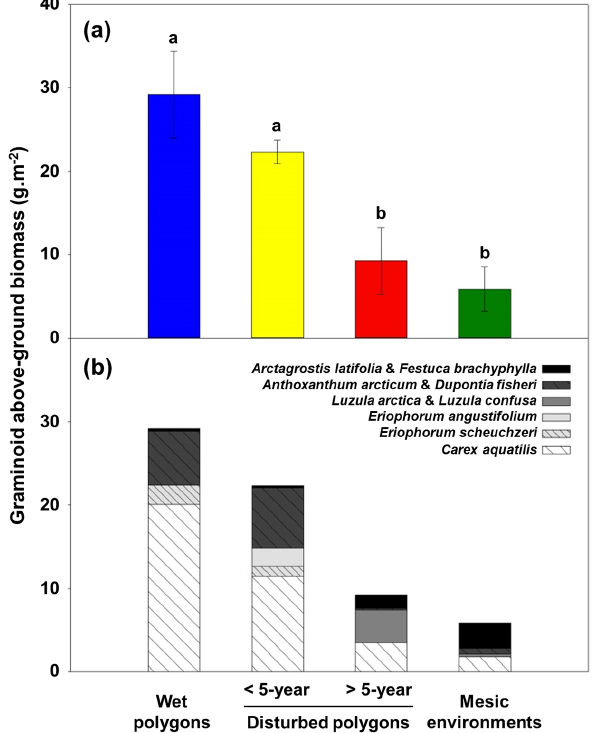
Figure 5. Above-ground biomass of graminoids growing in the four habitat types studied in the Qarlikturvik valley, Bylot Island, Nunavut. (a) Mean total biomass ( ± SE), and (b) mean biomass per species. In panel (b) , dashes represent hydrophilic species. n = 5 per habitat. Species aforementioned belong to the following fam- ilies: Cyperaceae ( Carex aquatilis , Eriophorum angustifolium and Eriophorum scheuchzeri ), Juncaceae ( Luzula arctica and Luzula confusa ), and Poaceae ( Anthoxanthum arcticum , Arctagrostis lati- folia , Dupontia fisheri and Festuca brachyphylla